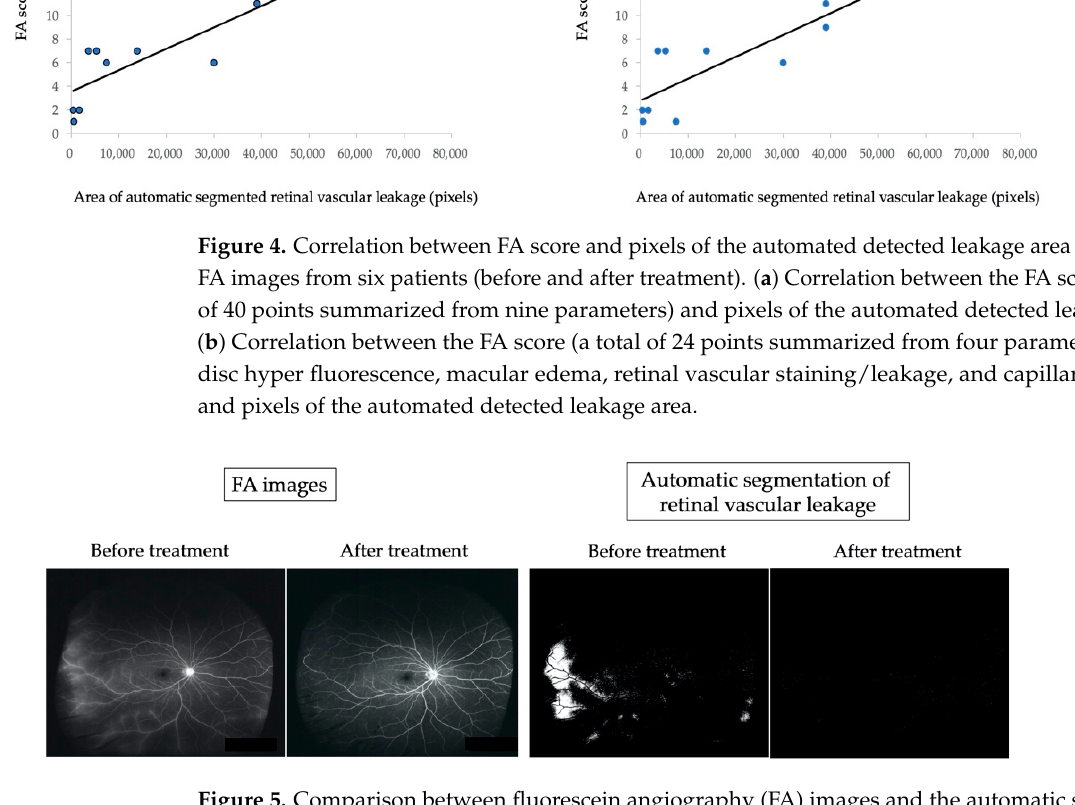
Figure 5. Comparison between fluorescein angiography (FA) images and the automatic segmented vascular leakage area before and after therapy in a representative case (idiopathic uveitis).